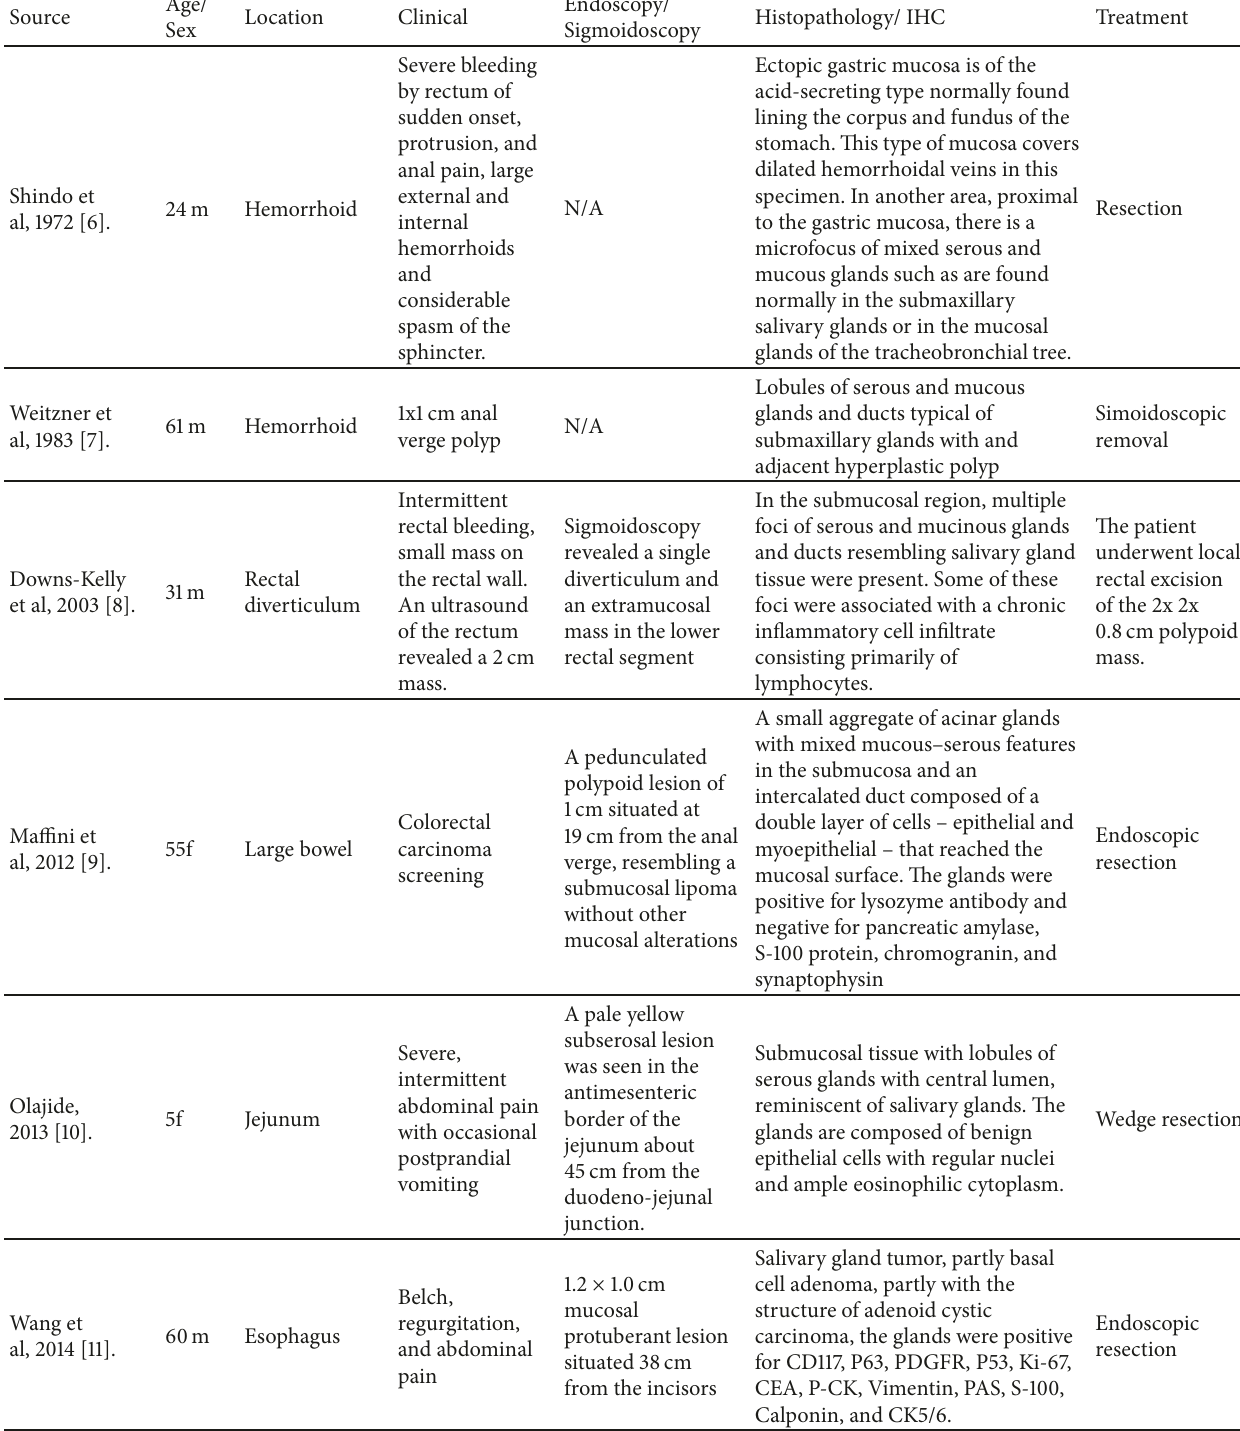
Table 2: Location, clinical features, endoscopic/sigmoidoscopic findings, histopathology, and treatment of 6 cases of gastrointestinal salivary gland choristomas reported in the